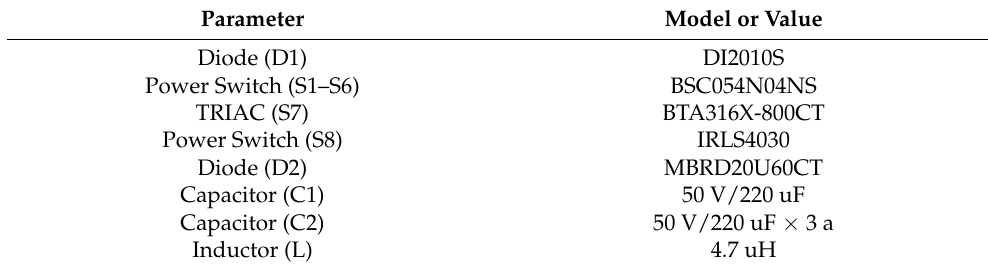
Table 1. Parameter with value of hardware device.